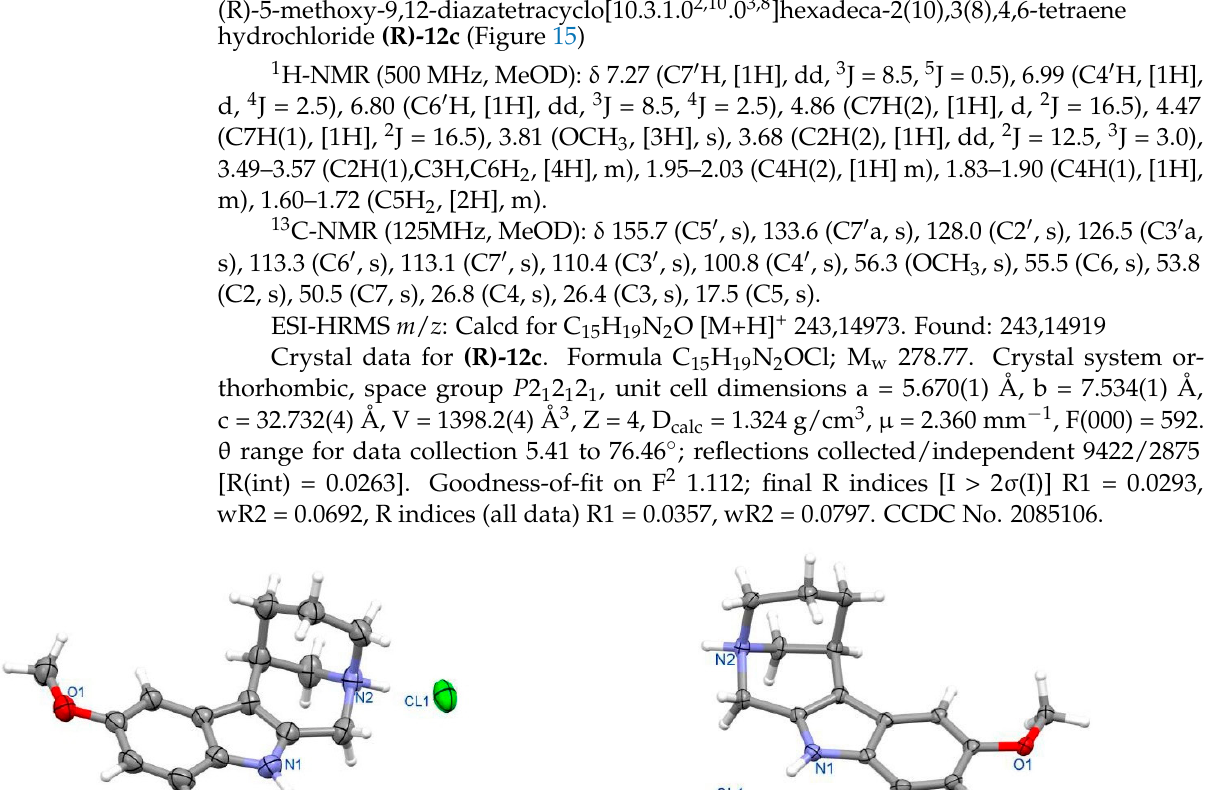
Figure 14. Numbering system for NMR spectra interpretation of compounds (R)- 12c and (S) -13c .